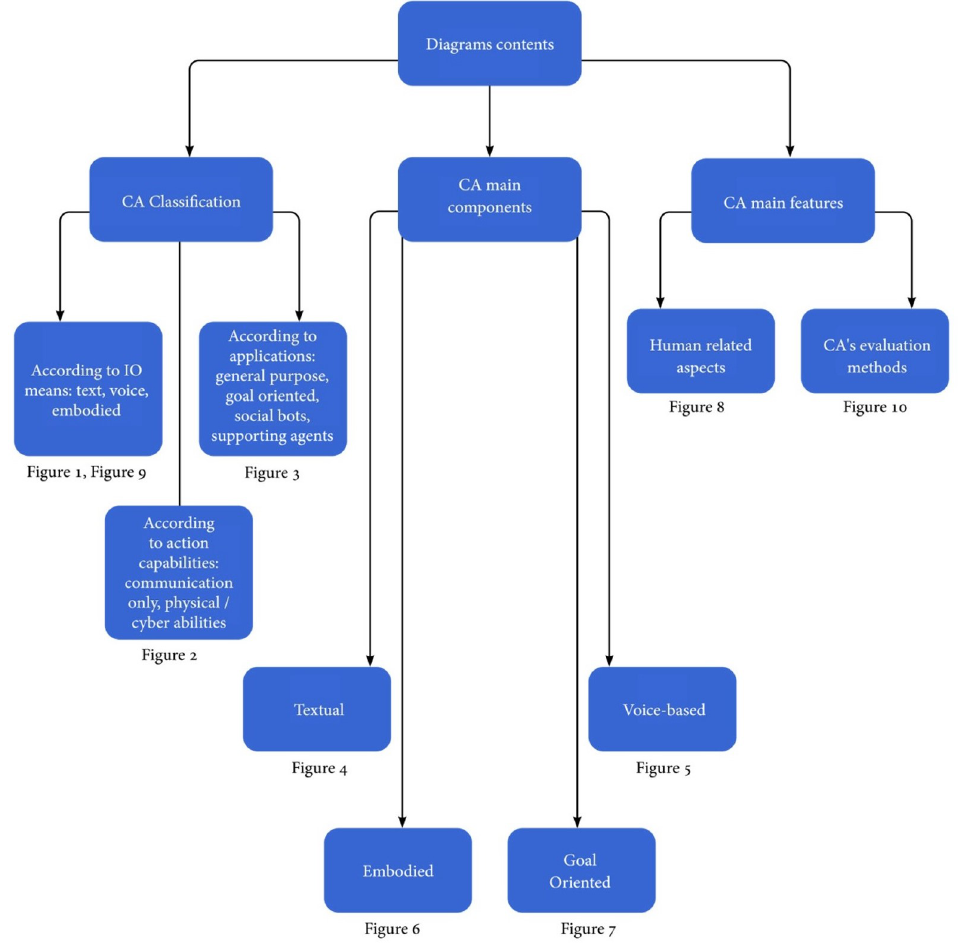
Figure 11. A summary of all